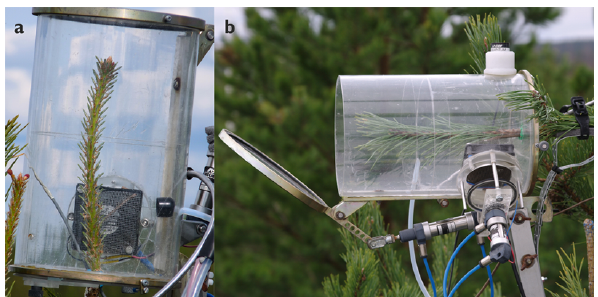
Fig. 1. Emission measurements with dynamic shoot enclosures. (a) The enclosure with a developing Scots pine shoot at the end of May, when the intensive needle elongation period begins. (b) The enclo- sure with a mature Scots pine